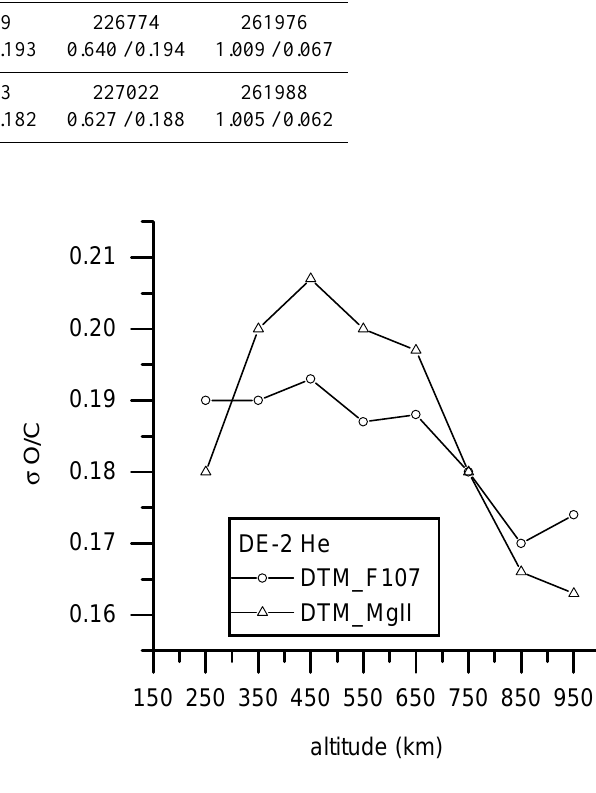
Fig. 7. The scatter of the DE-2 molecular nitrogen residuals pre- sented in latitude bins.